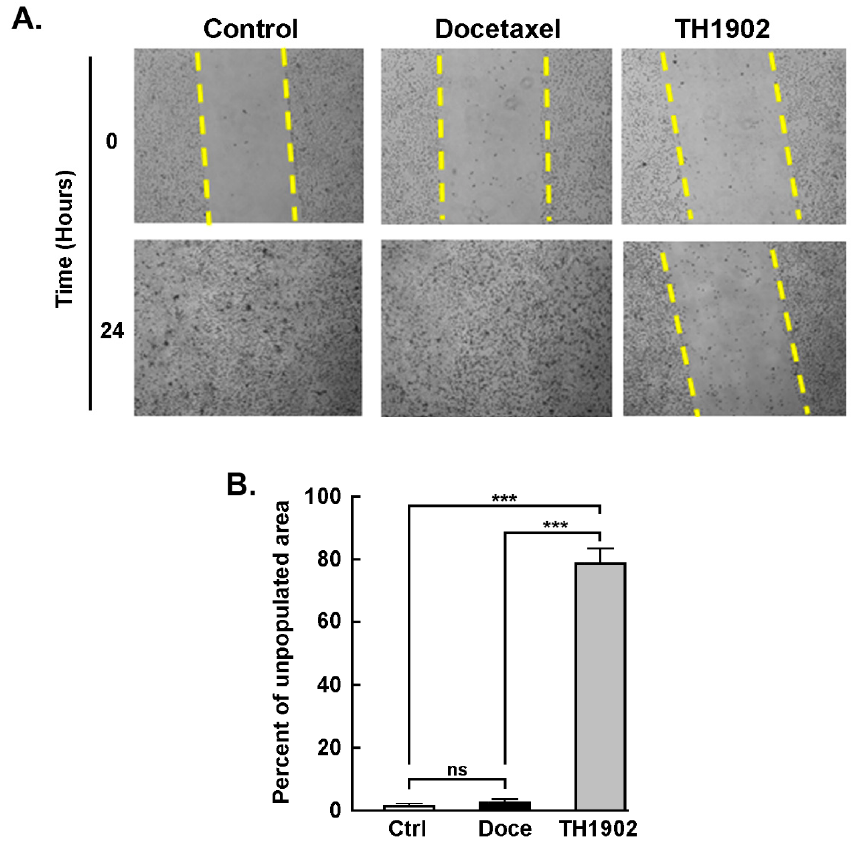
Figure 3. TH1902 inhibits CSC migration . ( A ) Pictures of wells bearing confluent layers